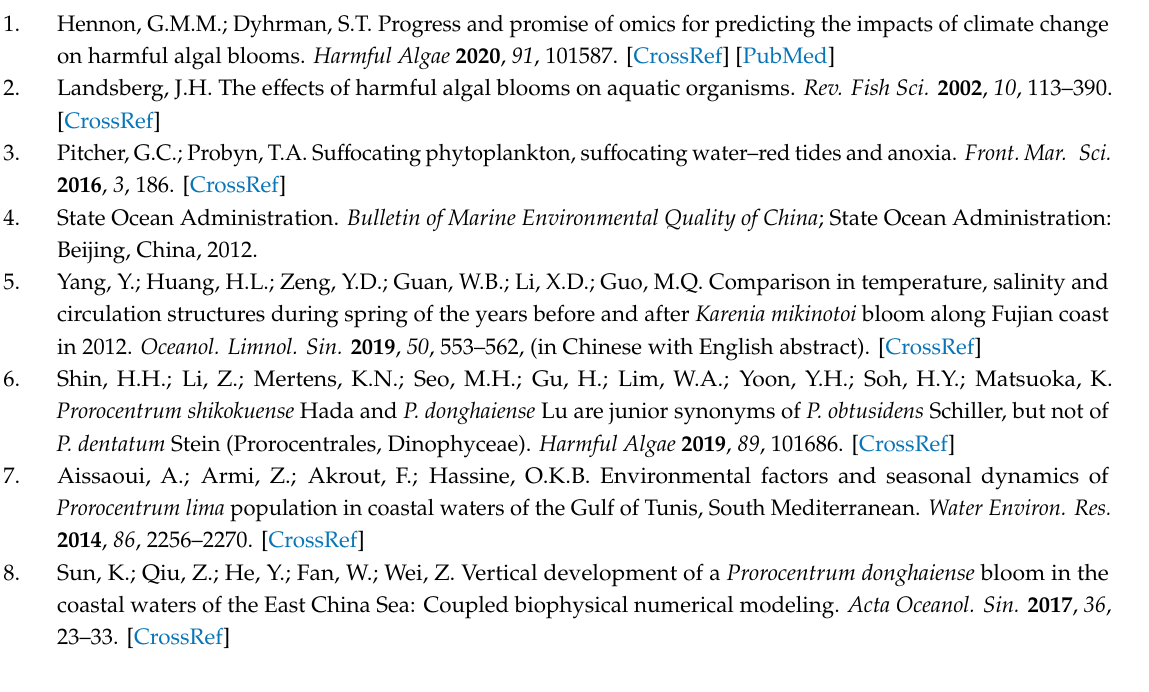
Table S1: sampling information during the cruises in May and July 2019 in Taiwan Strait; Table S2: results of correlationcoe ffi cientbetweencelldensityofdinoflagellateordiatomandenvironmentaldriversduringtwocruises; Table S3: results of correlation coe ffi cient between cell density of Prorocentrum donghaiense and environmental drivers during the cruise in May 2019; Figure S1: correlations of cell density of dinoflagellates (left) or Prorocentrum donghaiense (right) with temperature (a,h), salinity (b,i), measured DO concentration (c,j), pH value (d,k), DIN concentration (e,l), DIP concentration (f,m), and DIN:DIP ratio (g,n) in the surface water of the Taiwan Strait during the cruise in May and July 2019; Figure S2: correlations of cell density of dinoflagellates with temperature (a), salinity (b), measured DO concentration (c), pH value (d), DIN concentration (e), DIP concentration (f), and DIN:DIP ratio (g) in the surface water of the Taiwan Strait during the cruise in May 2019; Figure S3: correlation of measured dissolved oxygen (DO) concentration with temperature (a), and correlation of apparent DO concentration with chlorophyll a (Chl a ) (b) or cell density (c) of dinoflagellate in the surface water of the Taiwan Strait during the cruises in May and July